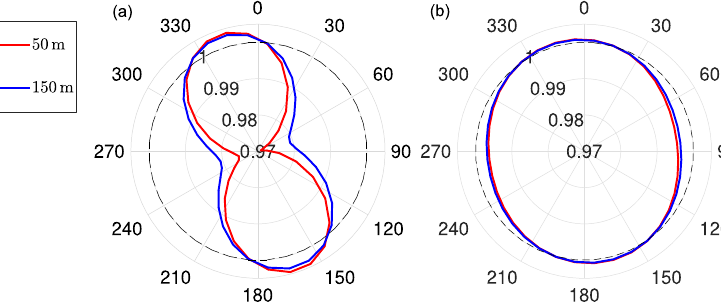
Figure 8. Directional orography effects O ( x,z, dd) at x = 500m (a) and x = 2950m (b) from the coast at two heights above mean sea